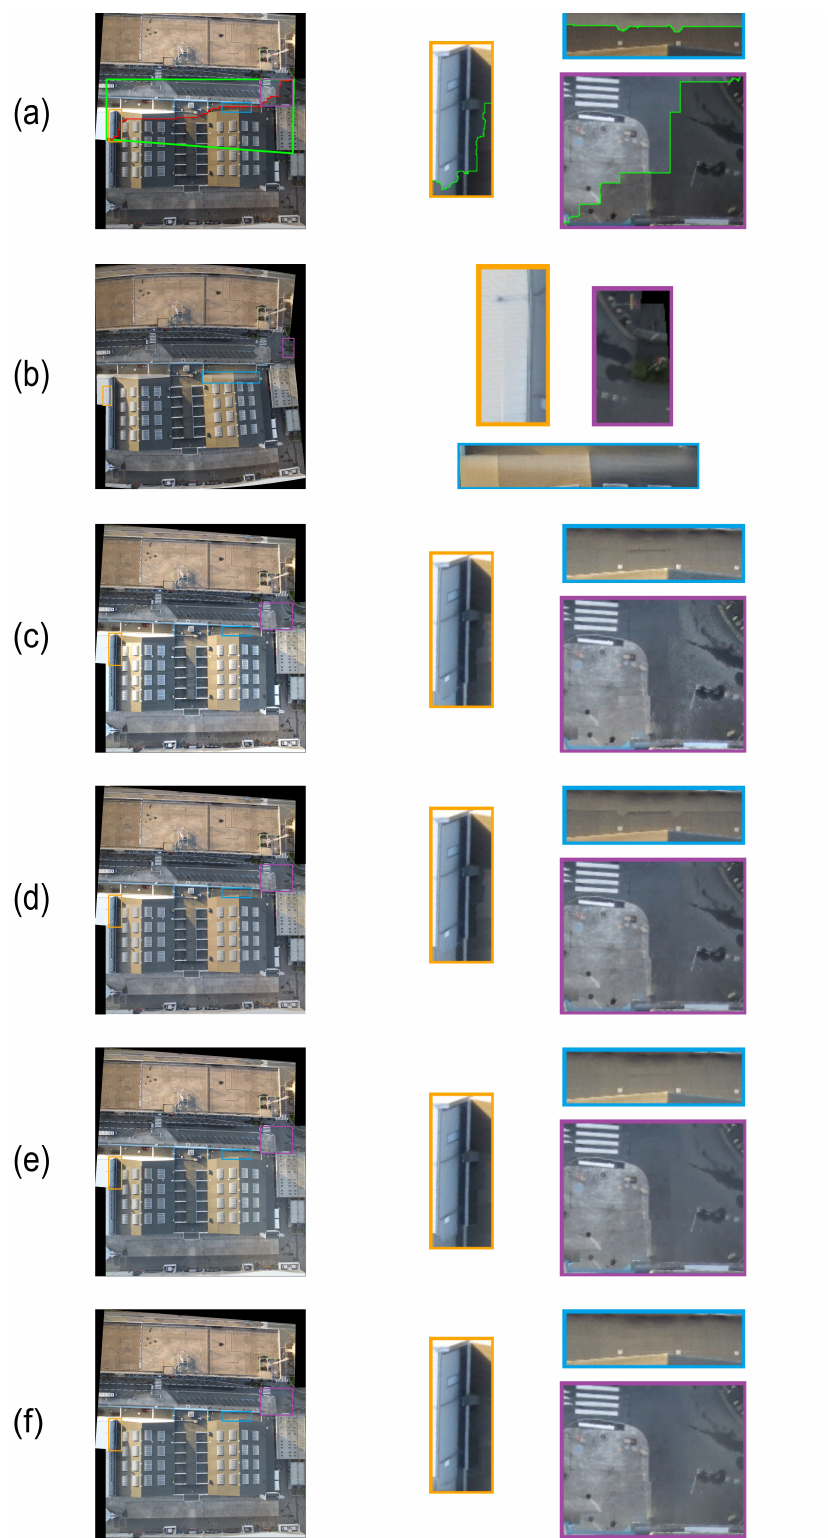
Figure 8. The perceptual quality merit of our method for the first testing stitched image taken from S 0 . ( a ) The testing stitched image and the amplified sub-images near the stitching line. ( b ) The MBB method [18]. ( c ) The HM-based method [19]. ( d ) The GP-based method [21]. ( e ) The GBJI-based method [23]. ( f ) Our